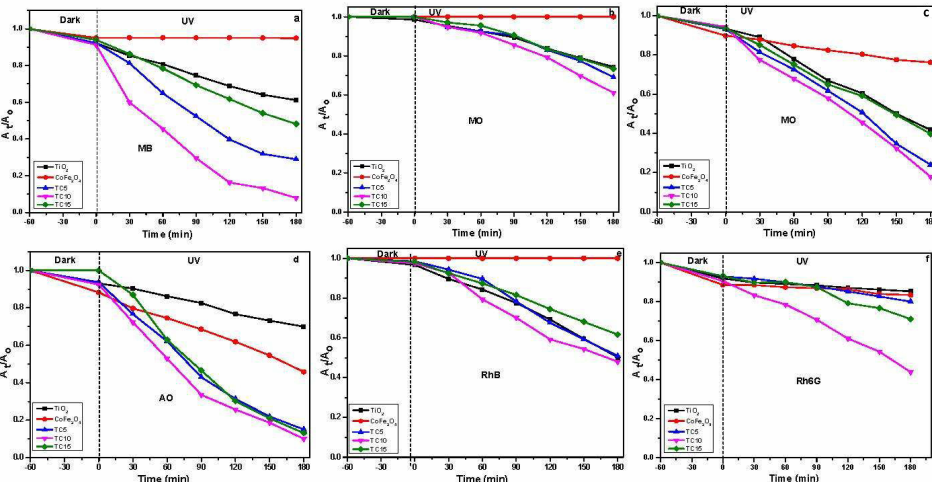
Figure 10. Photocatalytic oxidative degradation of ( a ) Methylene Blue (MB), ( b ) Methyl Orange (MO), ( c ) Crystal Violet (CV), ( d ) Acridine Orange (AO), and ( e ) Rhodamine B (RhB and ( f )) Rhodamine 6G, under UV irradiation by the prepared